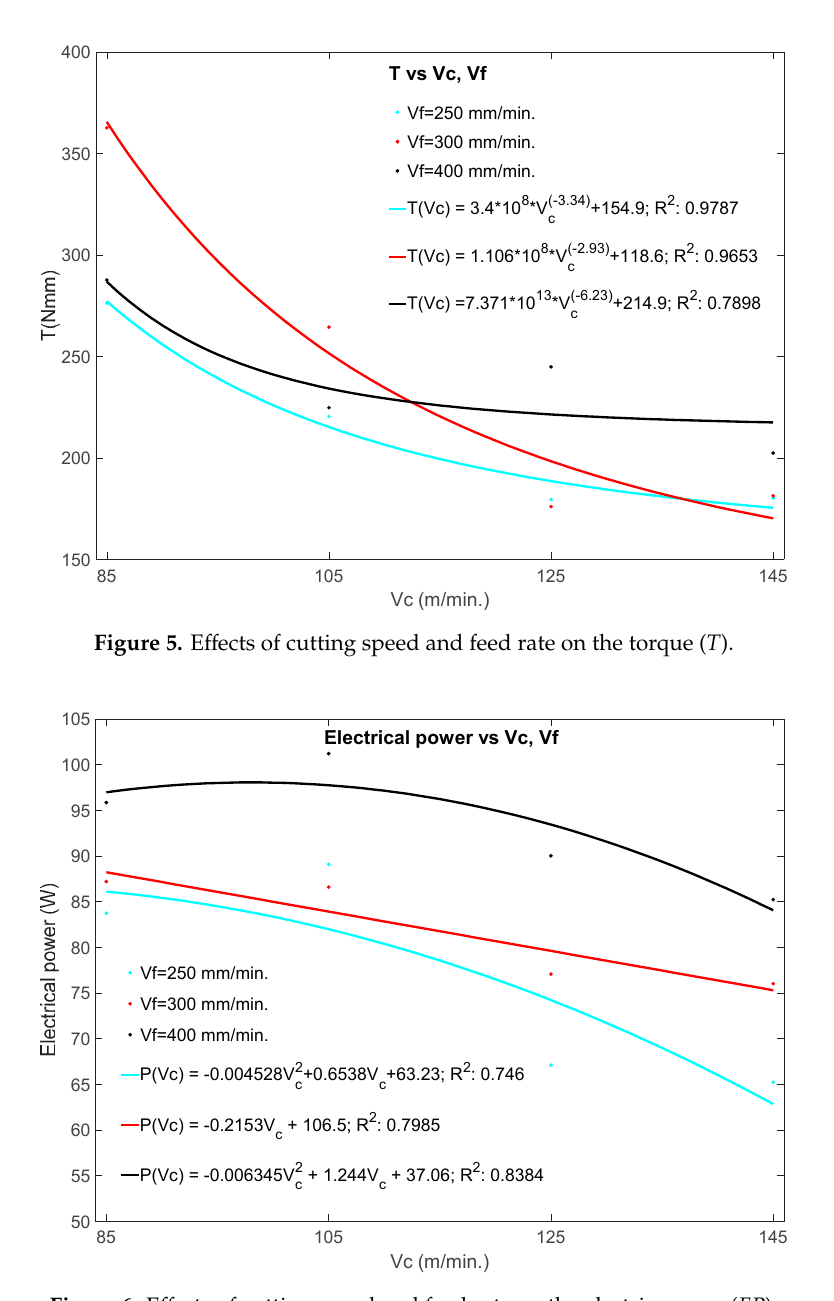
ff ects of cutting speed and feed rate on the electric power ( EP Figure 6. Effects of cutting speed and feed rate on the electric power ( EP ). Figure 6. E